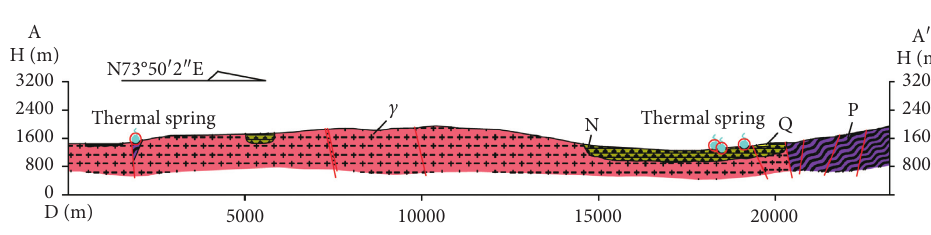
Figure 2: Schematic geological cross-sections of A-A ′ reported in Figure